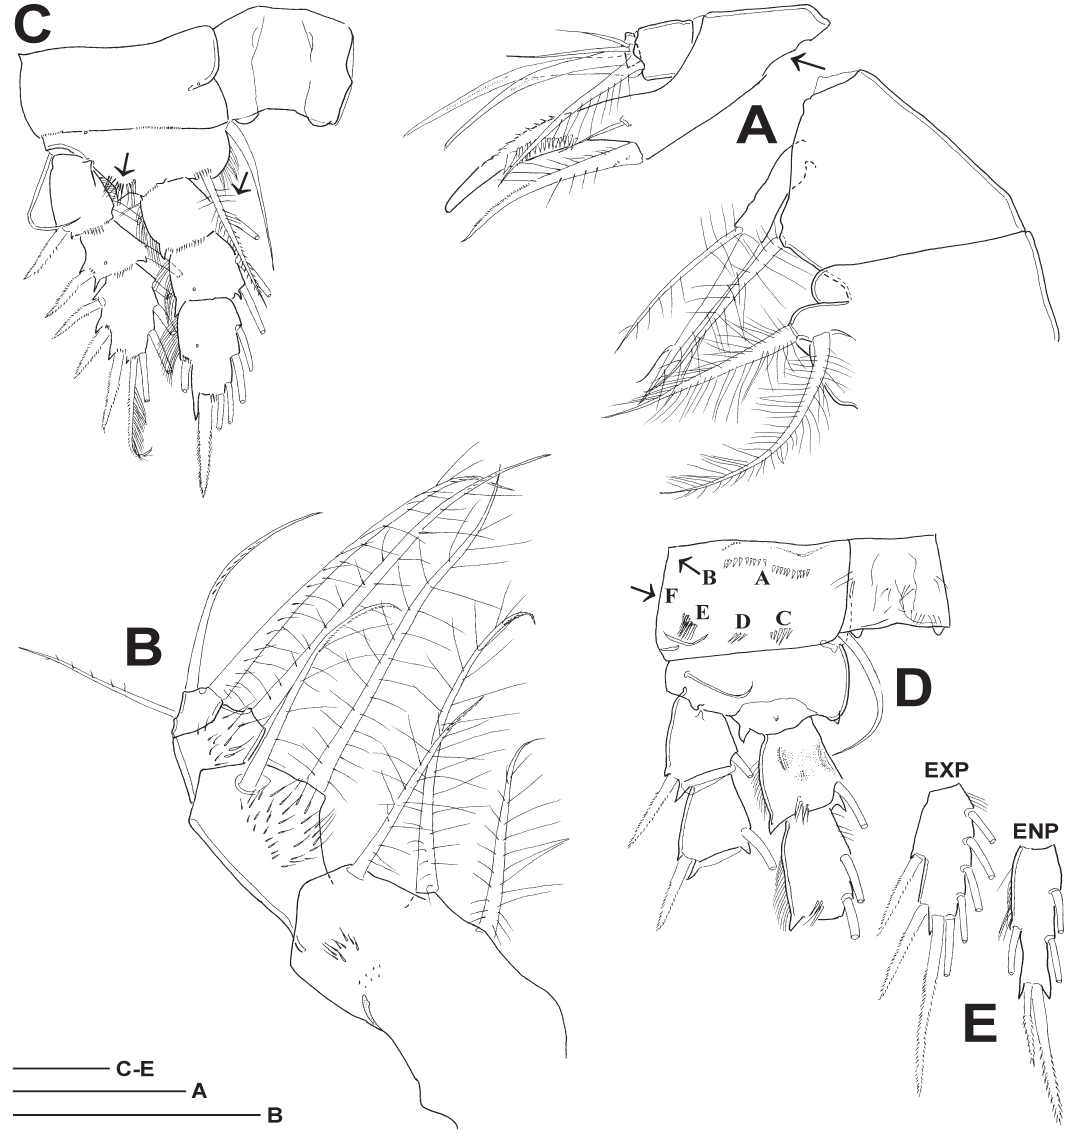
Fig. 3. Cyclops bohater koźmiński, 1933, ♀. A . maxilla, caudal. B . maxilliped, frontal. C . Leg 1, frontal, arrows point to the long setules of the medial spine/seta of basipodite, and long spinules on the basipodite between the insertions of exopodite and endopodite. D−E . Leg 4: eXP, P4 exp 3; enP, P4 enp3. all drawings show the lectotype (nHmUk 2016. 38). scale bars: a−e = 100